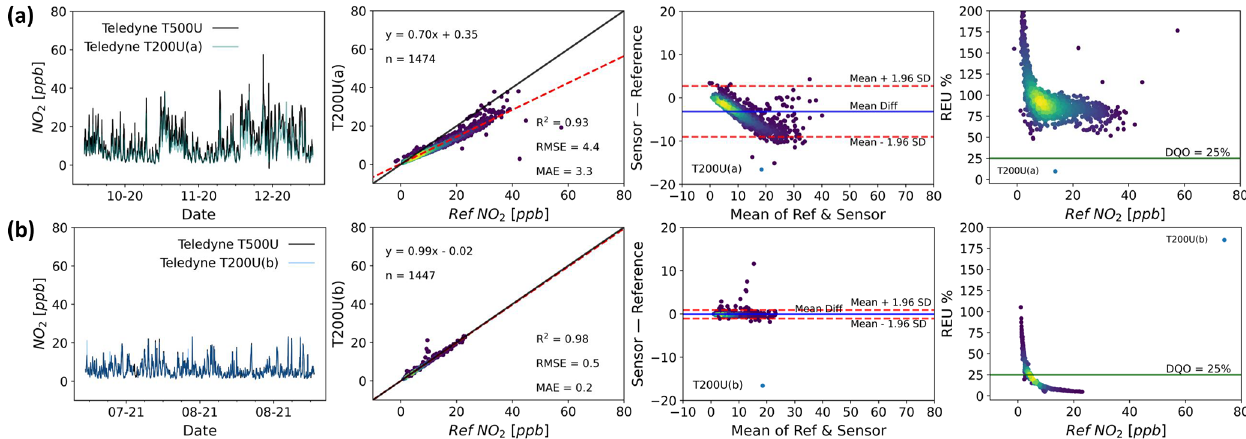
Figure 7. Time series (first column), regression (second column), Bland–Altman (third column) and REU (fourth column; DQO for NO 2 = 25%) plots for two identical (Teledyne T200U) reference NO 2 instruments (a, b) colocated at the Manchester Supersite (1h time resolution). The first instrument indicates the period between October and November 2020 and the second between July and August 2021. All but the time series plots have been coloured by data density. (Darker colours denote lower density and lighter colours denote higher